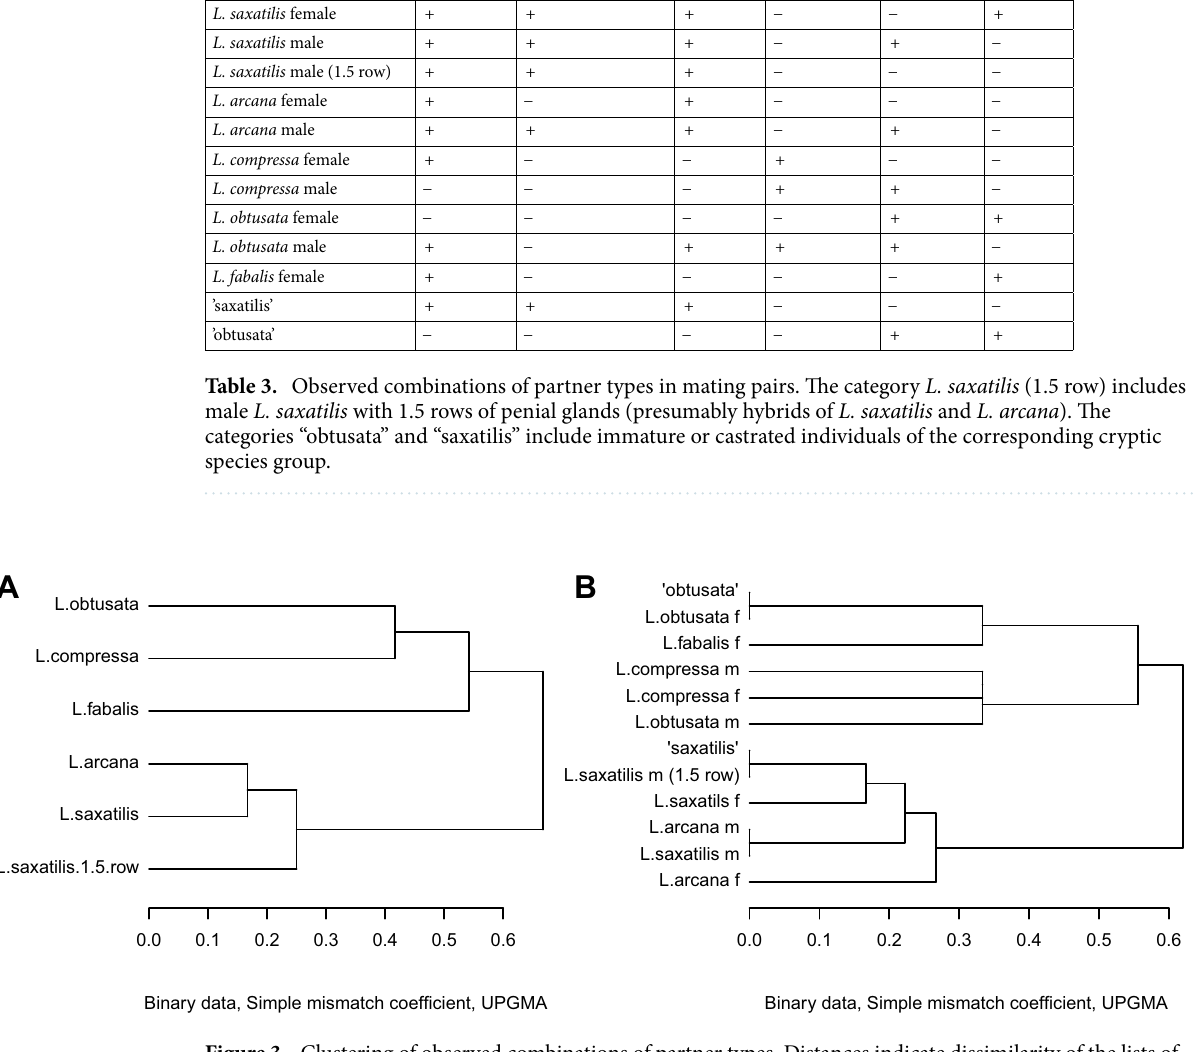
Figure 3. Clustering of observed combinations of partner types. Distances indicate dissimilarity of the lists of all observed partner types for active ( A ) and passive ( B ) mates (simple mismatch coefficient; Mirkin, 1996). The category L. saxatilis (1.5 row) includes L. saxatilis males with 1.5 rows of penial glands (presumably hybrids of L. saxatilis and L. arcana ). The categories “obtusata” and “saxatilis” include immature or castrated individuals of the corresponding cryptic species